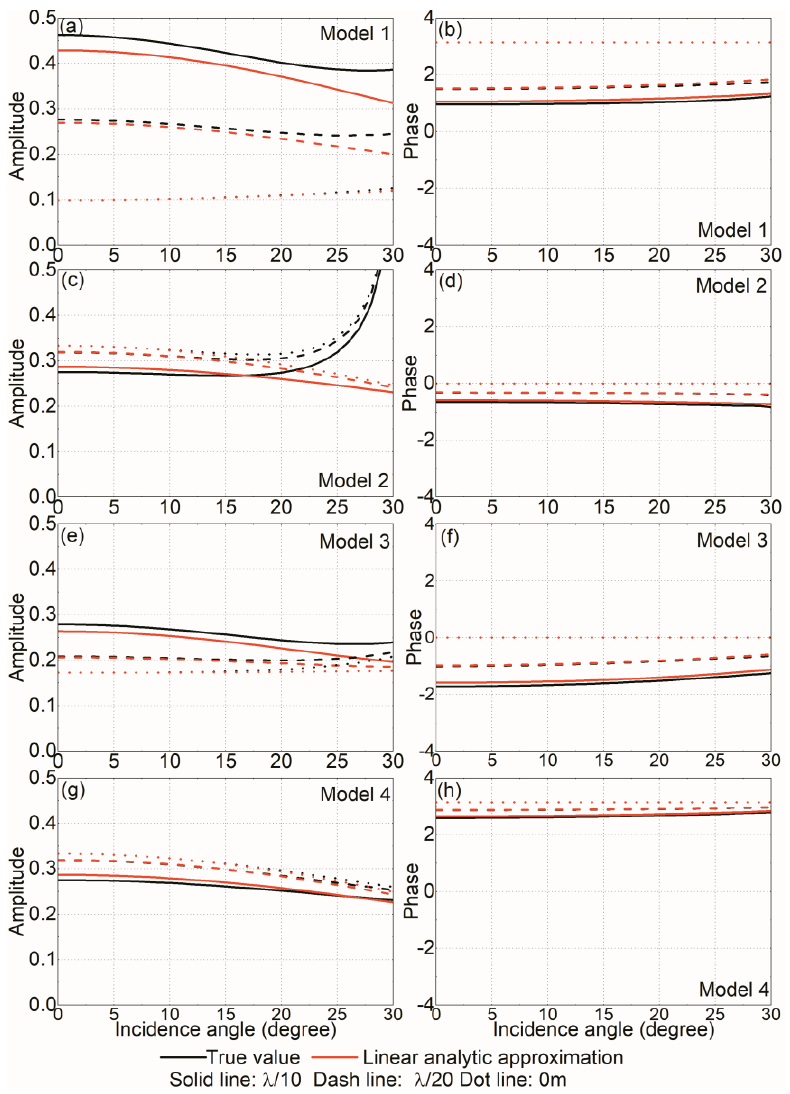
Figure 3. Comparison of the linear analytic approximation and the true value of P-wave reflection coefficients: ( a ) amplitude of Model 1; ( b ) phase of Model 1; ( c ) amplitude of Model 2; ( d ) phase of Model 2; ( e ) amplitude of Model 3; ( f ) phase of Model 3; ( g ) amplitude of Model 4; ( h ) phase of Model 4.